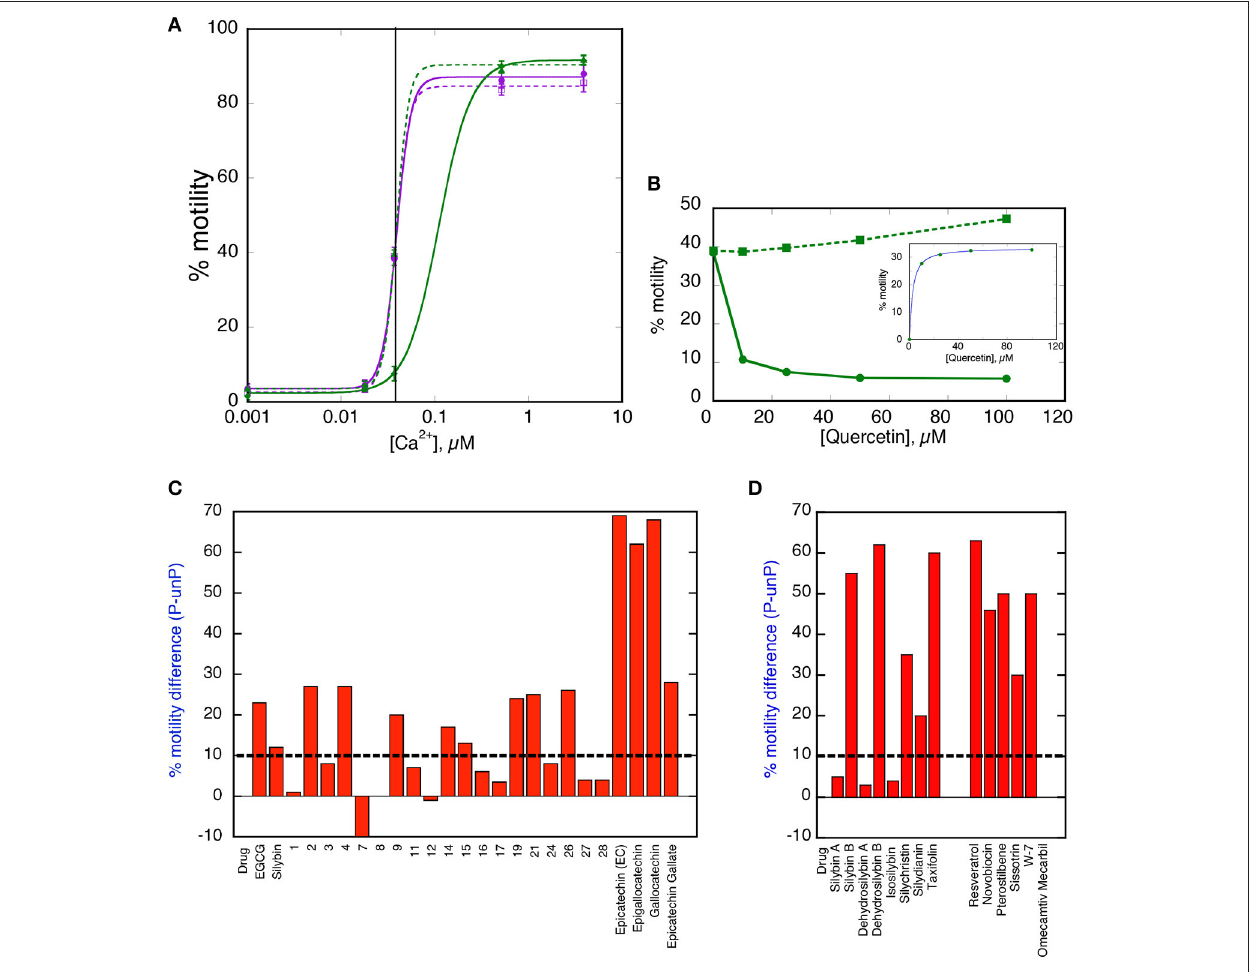
FIGURE 2 | Single [Ca 2 + ] screen for re-coupling compounds. (A) Ca 2 + -activation curves for phosphorylated and unphosphorylated thin filaments containing E180G tropomyosin in the presence and absence of 25 µ M Quercetin, a typical pure recoupler. Solid lines, phosphorylated state; dotted lines, unphosphorylated state. Purple lines and points, E180G thin filaments; green lines and points, E180G thin filaments + Quercetin (B) Dose -response curve for quercetin recoupling activity measured at a constant concentration of 0.037 µ M Ca 2 + . INSET, kinetic analysis of dose response curve; difference between phosphorylated and unphosphorylated states is plotted against quercetin concentration. The Hill equation is fitted to the data, EC 50 = 8 µ M. (C,D) The effect of 100 µ M drug treatment on the difference between % of motility of phosphorylated and unphosphorylated tropomyosin E180G mutant-containing thin filaments at 0.037 µ M Ca 2 + . (C) EGCG-related molecules (for structures 1–28 see Figure S1 and Table 1 ). (D) Silybin, related compounds and other HsP90 inhibitors and Ca 2 + desensitizers. The threshold for positive re-coupling was set at a 10% difference (dotted